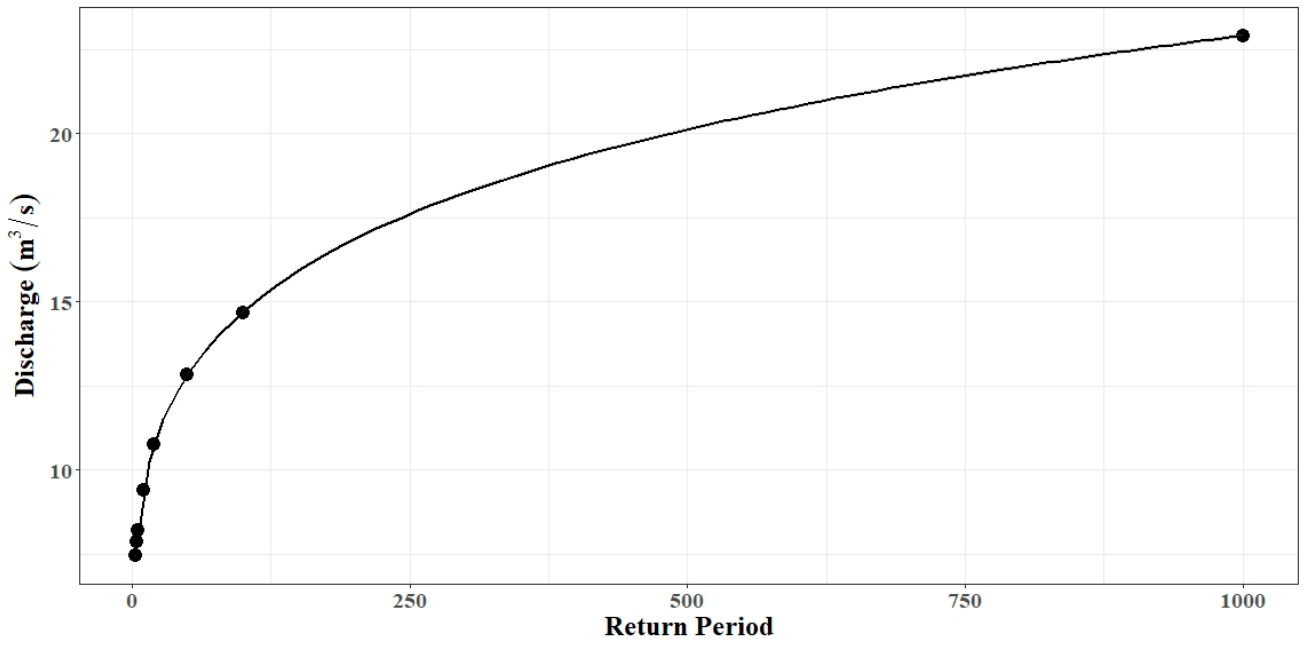
Figure 4. Peak flow–return period relationship of the Toba River.